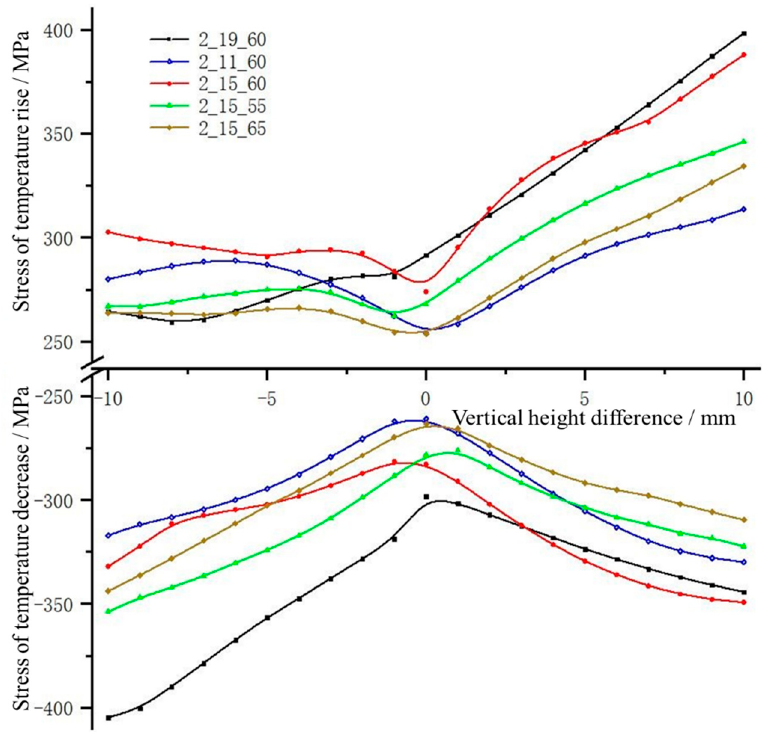
Figure 11. Bellows stress curve.